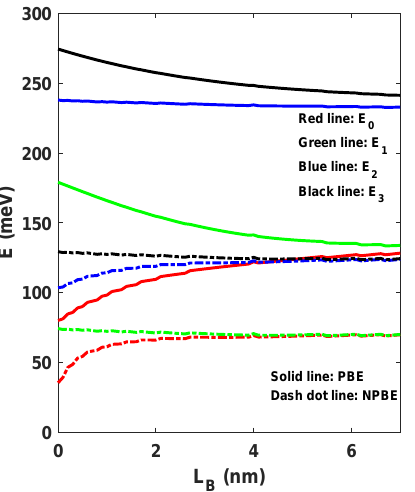
Figure 5. The ground state and the three excited states E 1 , E 2 and E 3 as a function of the barrier width L B .